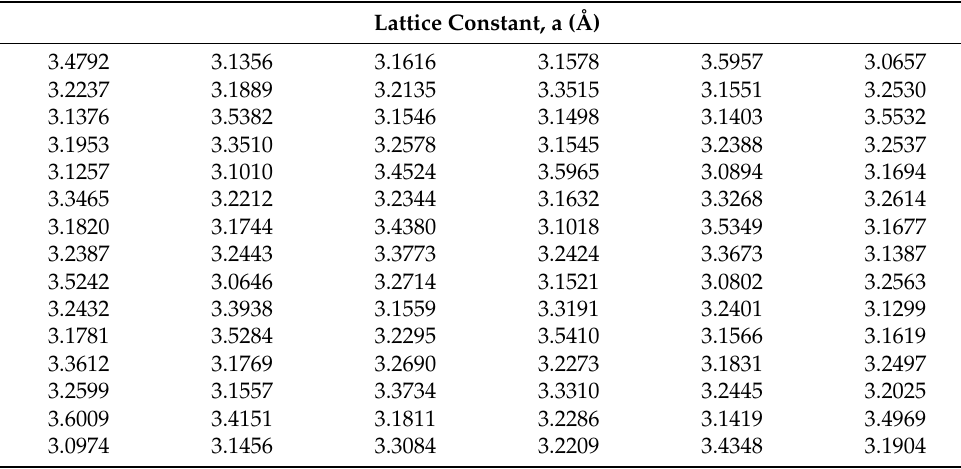
Table 2. The calculated lattice constants within a unit cell of Sc 0.29 Al 0.71 N. Lattice Constant, a (Å)